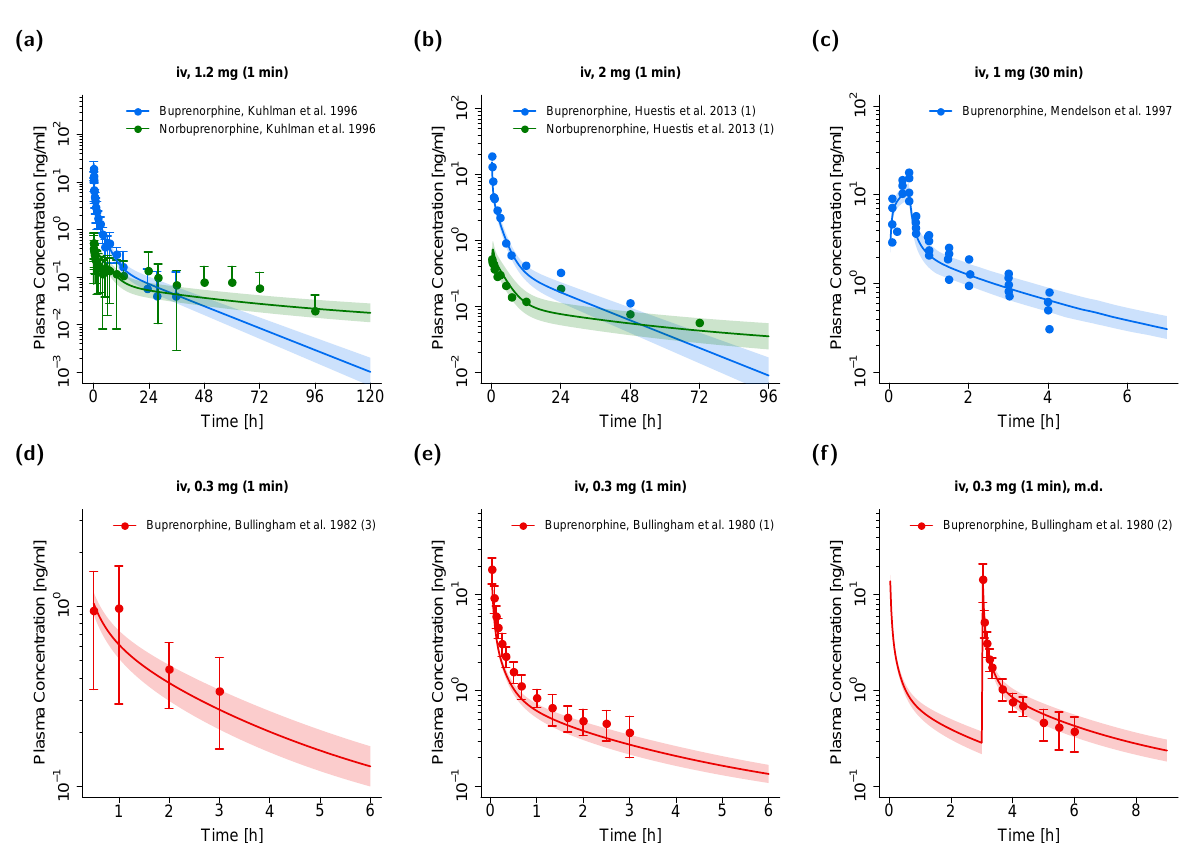
Figure 2. Buprenorphine (blue: venous blood, red: arterial blood) and norbuprenorphine (green: venous blood) predicted and observed plasma concentration-time profiles after intravenous administration of buprenorphine in adults. ( a , b ): selection of internal training dataset, ( c – f ): selection of external test dataset. Population simulations (n = 100) are shown as lines with shaded areas. Observed data are shown as circles ± standard deviation if available. References with numbers in parentheses link to a specific observed dataset described in the study table (Table 1). Predicted and observed area under the concentration-time curve from the first to the last data point (AUC last ) and maximum plasma concentration (C max ) values are compared in Table S6 of the Supplementary Materials. Predicted and observed plasma concentration-time profiles of all studies in adults are shown in Section 4.1 of the Supplementary Materials both on a linear and a semilogarithmic scale. iv: intravenous, m.d.: multiple